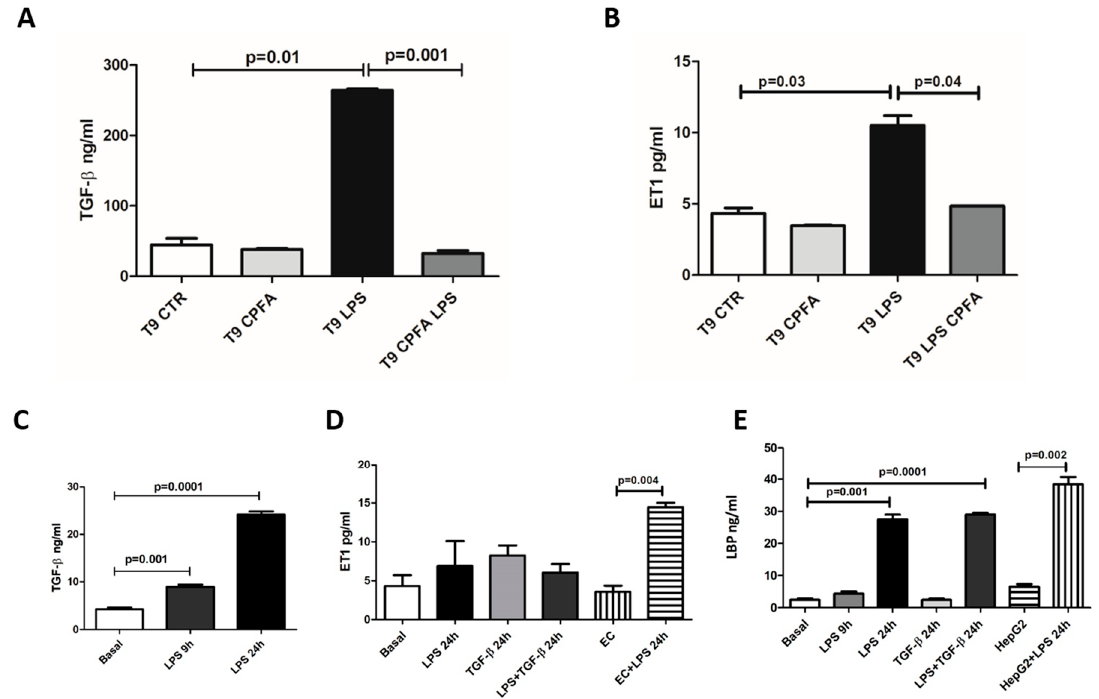
Figure 5. CPFA treatment modulated serum levels of TGF- β and ET-1, and LPS-stimulated pericytes secreted TGF- β and LBP. ( A , B ) Serum levels of TGF- β and ET-1 significantly increased after 9 h of LPS infusion compared to healthy pigs. Interestingly, CPFA-treated pigs presented a dramatic reduction in serum TGF- β and ET-1 levels. Data are expressed as median ± IQR of five independent pigs for each group. Statistically significant di ff erences were assessed by the Mann–Whitney test. ( C – E ) cultured pericytes were stimulated with LPS and / or TGF- β , and their supernatants were analyzed by ELISA. Human endothelial cells (EC) and human liver hepatocellular cells (HepG2) were used as control positive for ET-1 and LBP synthesis, respectively.( C ) LPS augmented TGF- β production in pericytes, particularly at 24 h. ( D ) LPS and / or TGF- β stimulation did not increase ET-1 production compared with EC treated with LPS for 24 h (positive control). ( E ) After 24 h from LPS stimulation, pericytes significantly increased LBP synthesis. Stimulation of pericytes with TGF- β alone did not influence LBP production. HepG2 stimulated with LPS for 24 h were used as positive control. Data were shown as mean ± standard deviation (SD) and compared with the Student t